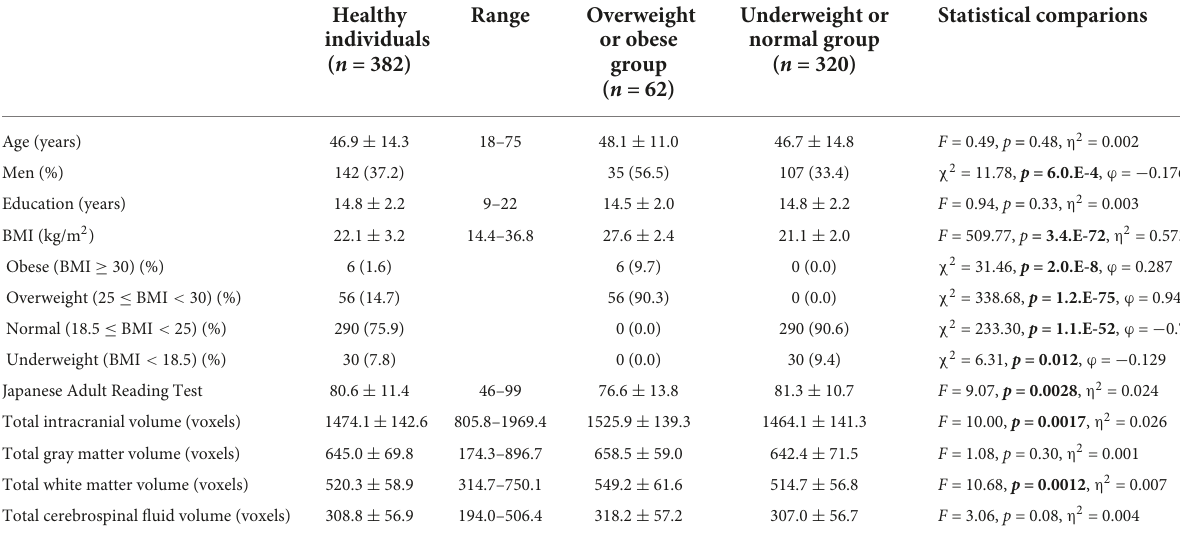
Healthy Range individuals ( n = 382)